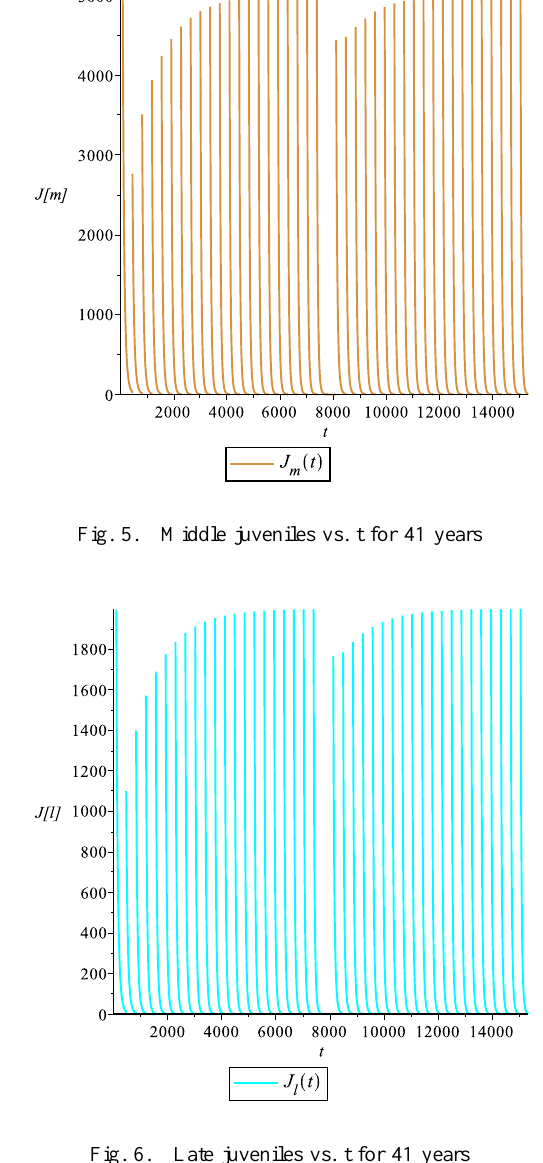
Fig. 6. Late juveniles vs. t for 41